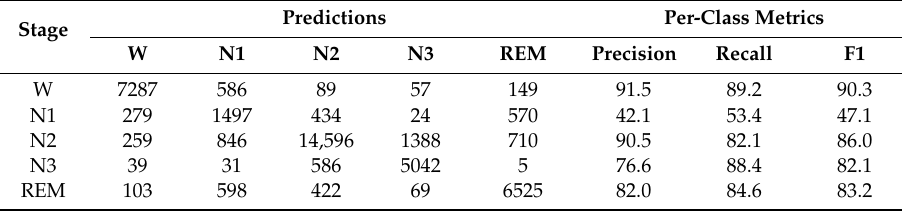
Table 4. Confusion matrix and overall performance on the sleep-edfx dataset.